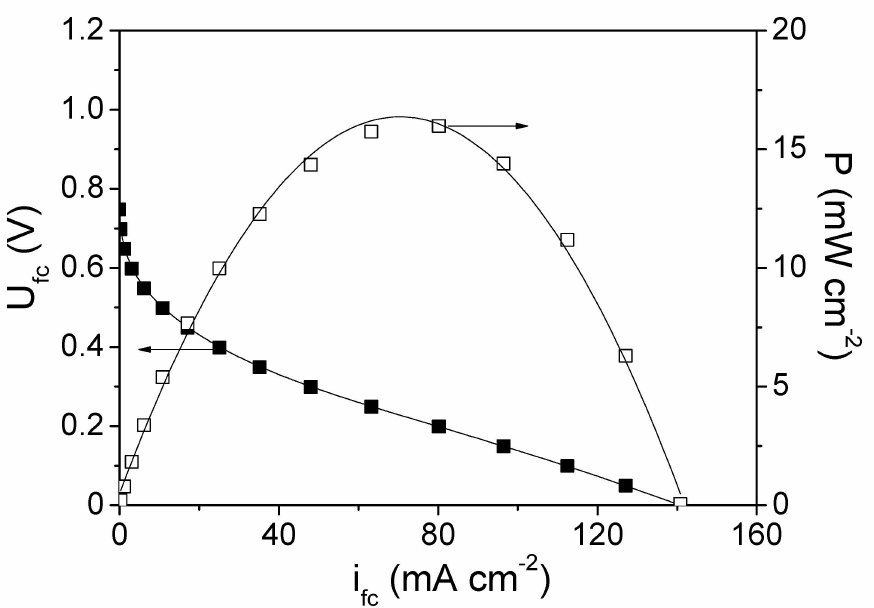
Figure 4. Cell potential ( U fc ) vs. current density ( i fc ) and power density ( P ) vs. current density ( i fc ) curves obtained for the PEMFC with the 22Pd—7Zn cathode electrode; Flow rates: F anode (100% H 2 ) = F cathode (synthetic air) = 100 cm 3 min − 1 ; geometric electrode surface area, A elec = 5.29 cm 2